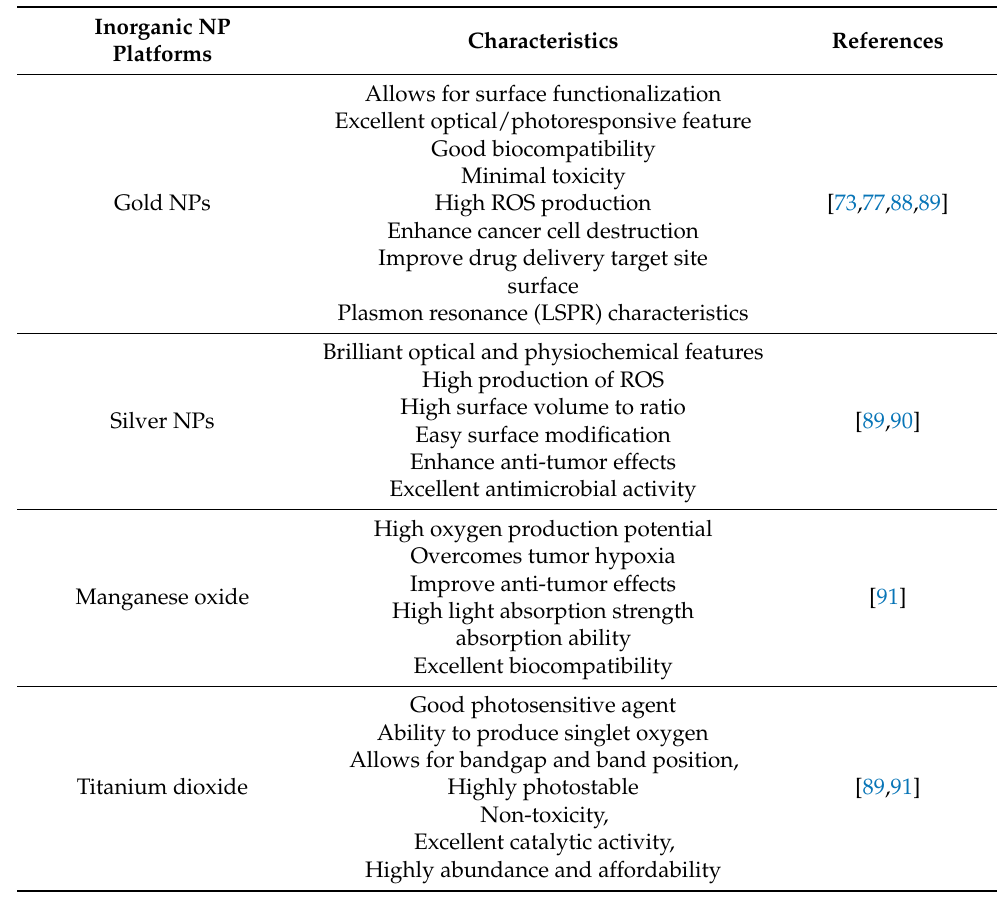
Table 2. Inorganic NP platforms and characteristics applied for targeted PDD and PDT.